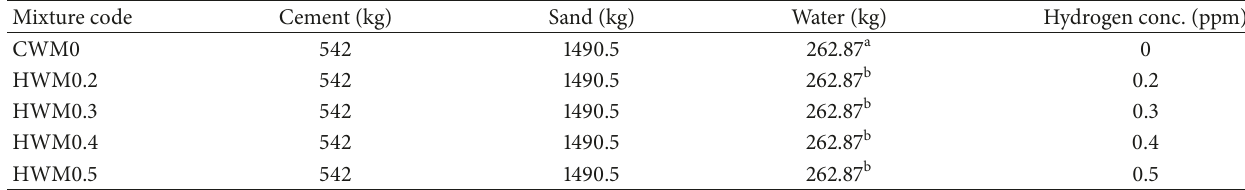
Table 2: Mix proportions of mortar mixtures for 1m 3